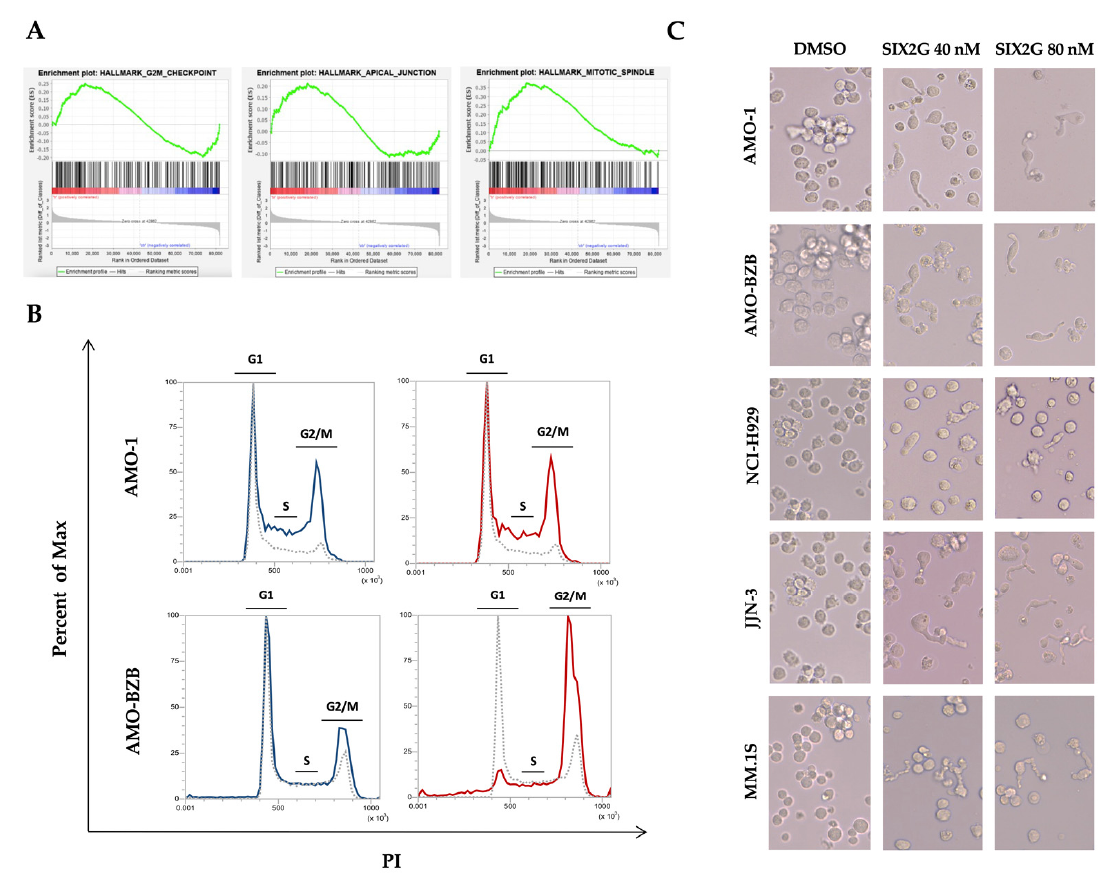
Figure 5. Evaluation of MTAs-induced effects. GSEA was performed on data obtained from GEP of AMO-1 cells treated with SIX2G at the EC 50 concentration (40 nM). Differentially expressed genes (SIX2G vs DMSO treated cells) were identified by applying a FC ≤ − 1.5 or ≥ 1.5 and a p -value < 0.05. The mainly perturbed pathways are represented ( A ). Representative flow cytometric analyses of PI stained cells are indicative of cell cycle distribution of AMO-1 and AMO-BZB 24 h after treatment with SIX2G at 40 nM (Blue Line) and 80 nM (Red line). Data were compared with respect to DMSO treated cells (gray dashed line) ( B ). Representative pictures of the morphological changes induced by SIX2G 24 h after treatment ( C ) Magnification